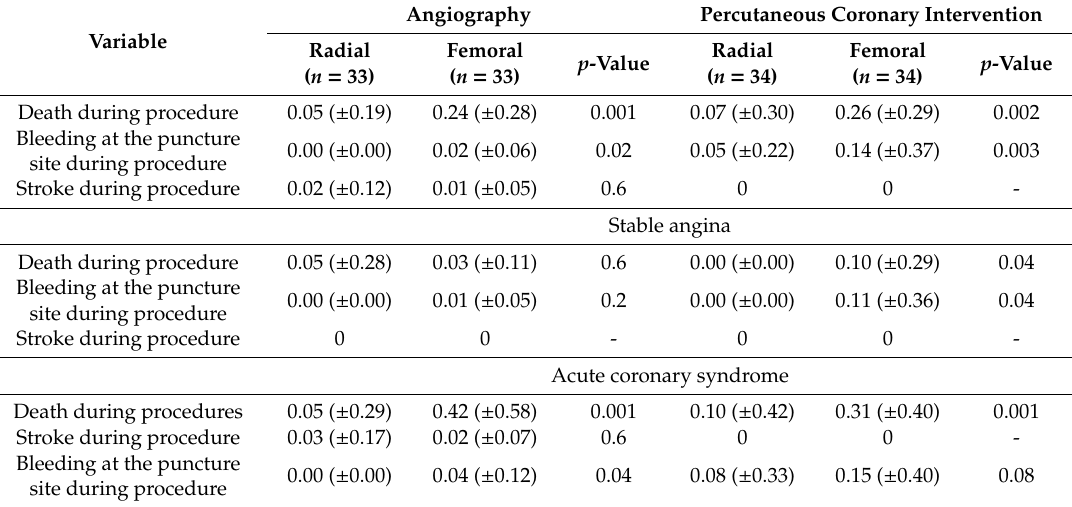
Table 7. Comparison of event rates between procedures with radial and femoral access site for stable angina and acute coronary syndrome in a group of operators performing ≤ 25% of procedures with radial artery.